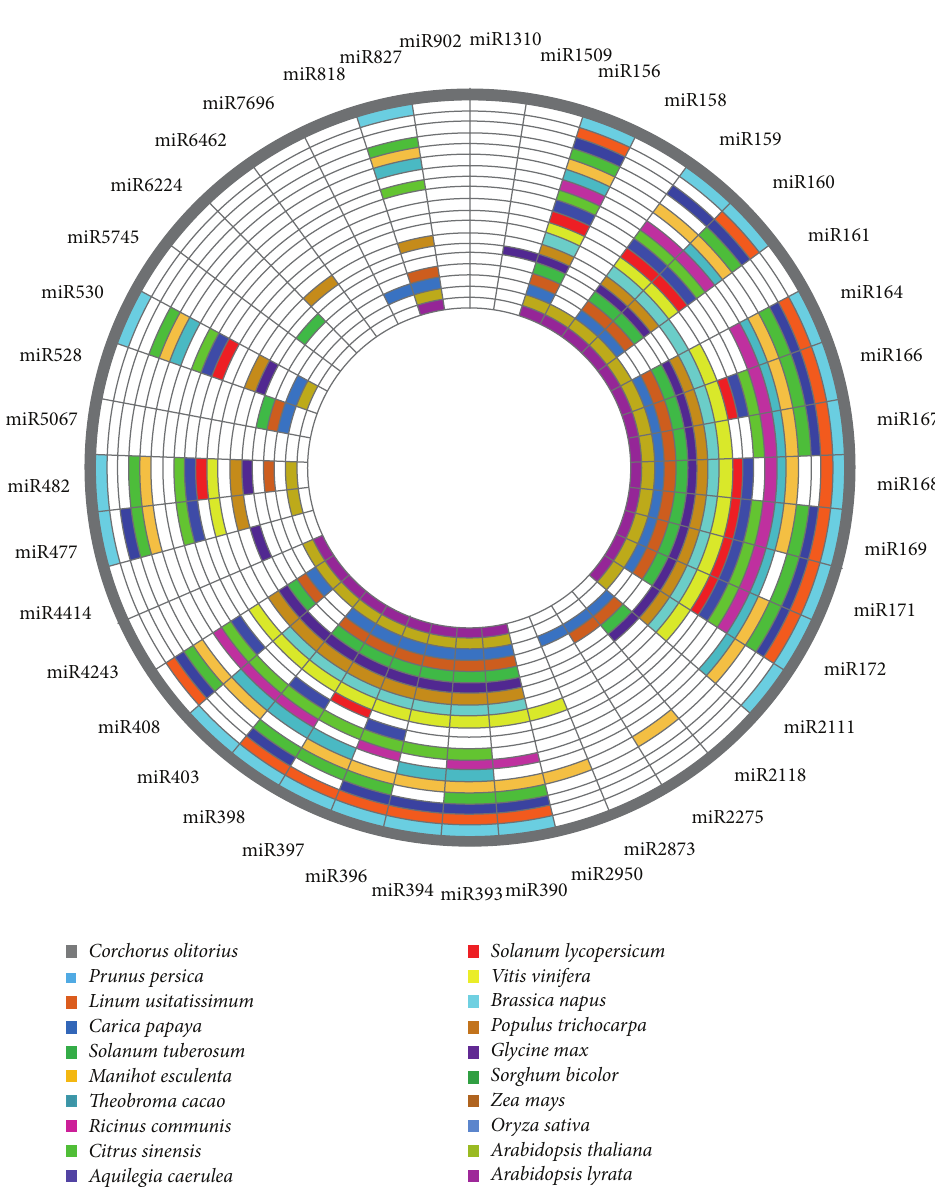
Figure 2: Conservancy of miRNAs identified in jute is presented as circular heat map among different model plants. Each color represents a different plant species and white color represents absence of miRNA. miRNA that was found in at least 9 plants was considered as